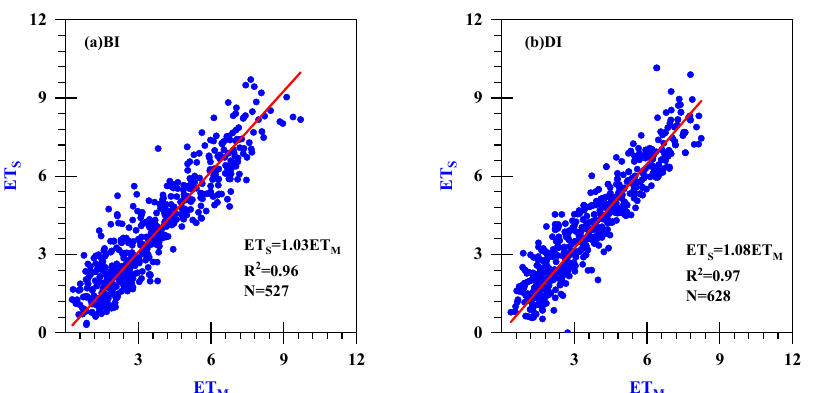
Figure 1. Comparison of simulated value of evapotranspiration (ET S ) by adjusted Shuttleworth- Wallace model and measured value of evapotranspiration (ET M ) over the maize field from 2014 to 2018 under film mulching border irrigation (BI) treatment and film mulching drip irrigation (DI) treatment.